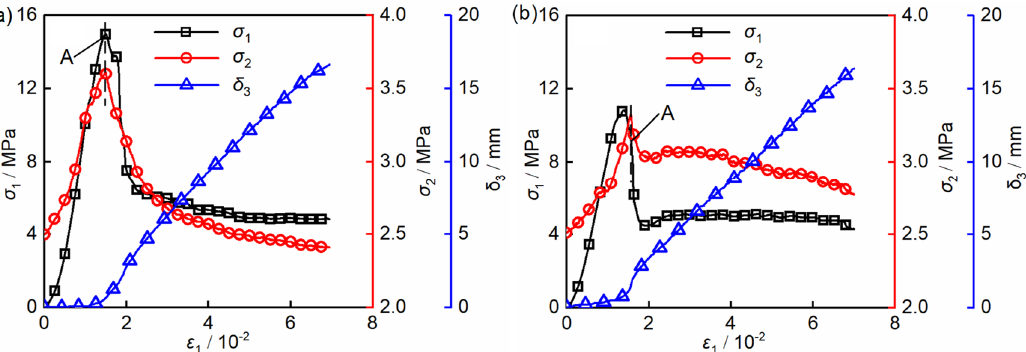
Figure 6. Typical stress–strain curves of bolted samples ( a ) without weak interlayer (Sample T-1); ( b ) with 25 mm thick weak interlayer (Sample T-6).